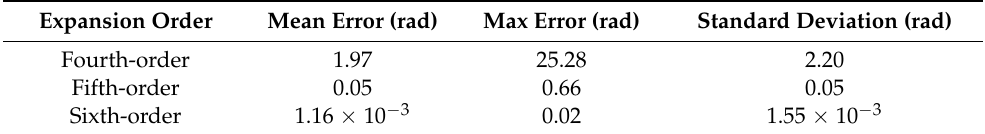
Figure 10. Pulse transmitting distance fitting error comparison of different order Taylor expansion. ( a ) Fourth-order; ( b ) fifth-order; and ( c ) sixth-order. Table 3. Pulse transmitting distance fitting error comparison of different order Taylor expansion.